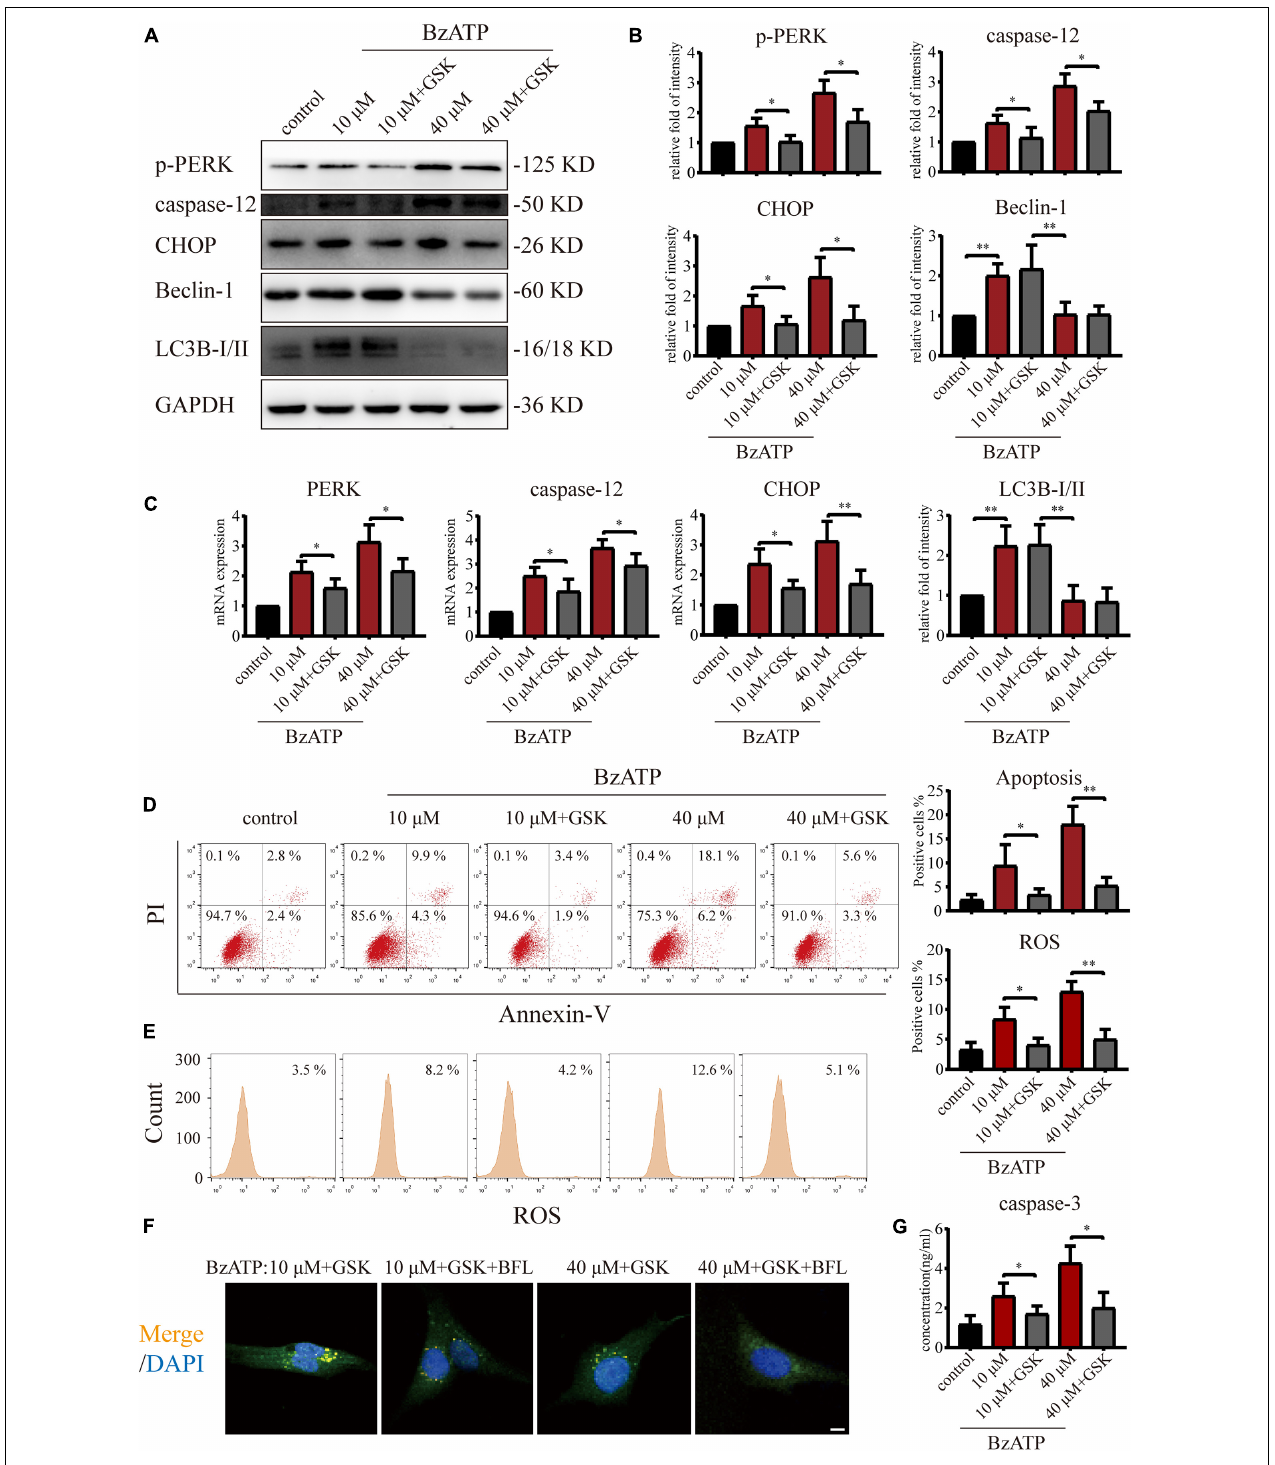
FIGURE 5 | Effect of PERK inhibition on autophagic flux and ER stress-apoptosis. Cells were cultured with 10 and 40 µ M of Bz-ATP, with or without 1 µ M GSK2606414 (GSK). Western blotting (A,B) and qRT-PCR (C) were used to detect the protein and mRNA expression levels of PERK , caspase-12 , CHOP , LC3B, and Beclin-1. Flow cytometry was used to detect the proportion of Annexin-V/PI double-stained cells (D) and the level of intracellular oxidative stress ROS (E) . (F) Cells were cultured with 10 µ M Bz-ATP, 1 µ M GSK2606414 (GSK), with or without Bafilomycin A1 (BFL). Immunofluorescence staining was used to observe the localization of autophagosomes and lysosomes (LC3B; green, Merge: yellow, DAPI: blue) (scale bar: 5 µ m). (G) The caspase-3 activity assay; the statistical results are homogenized. Data are expressed as means ± standard deviations of at least three independent experiments. ∗ p < 0.05, ∗∗ p < 0.01.